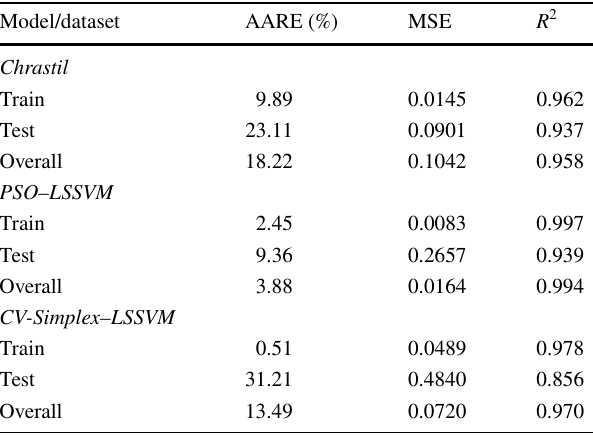
Table 2 Comparison between statistical parameters of Chrastil, PSO– LSSVM and CV-Simplex–LSSVM models in predicting n -alkane solubility in supercritical CO 2